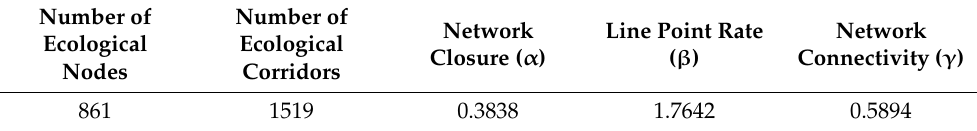
Table 2. Ecospatial network integrity